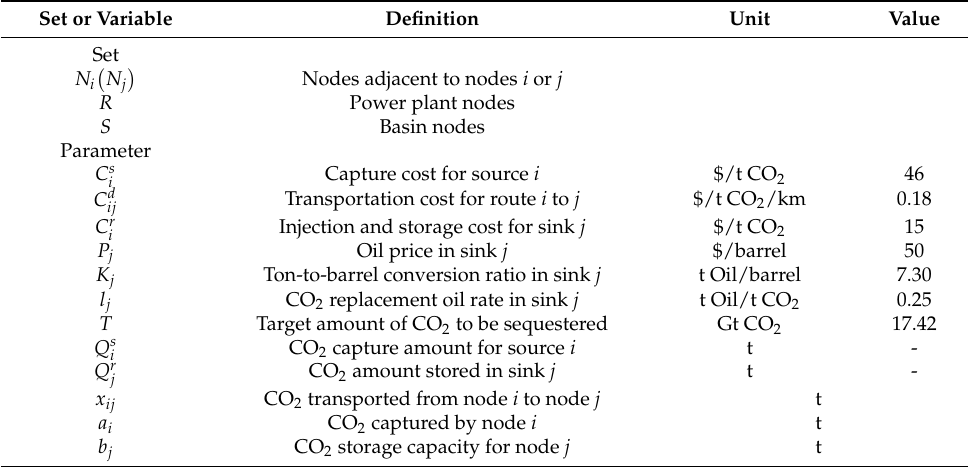
Table 2. Parameters and variables of the source–sink matching model.